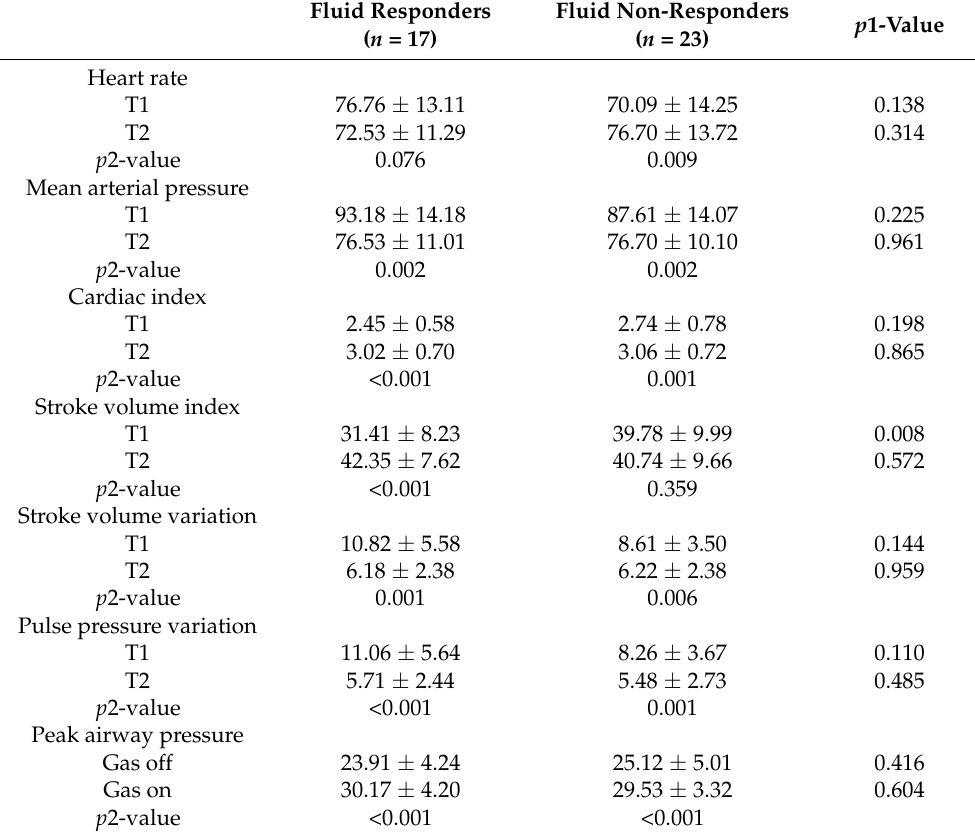
Table 2. Hemodynamic change in fluid